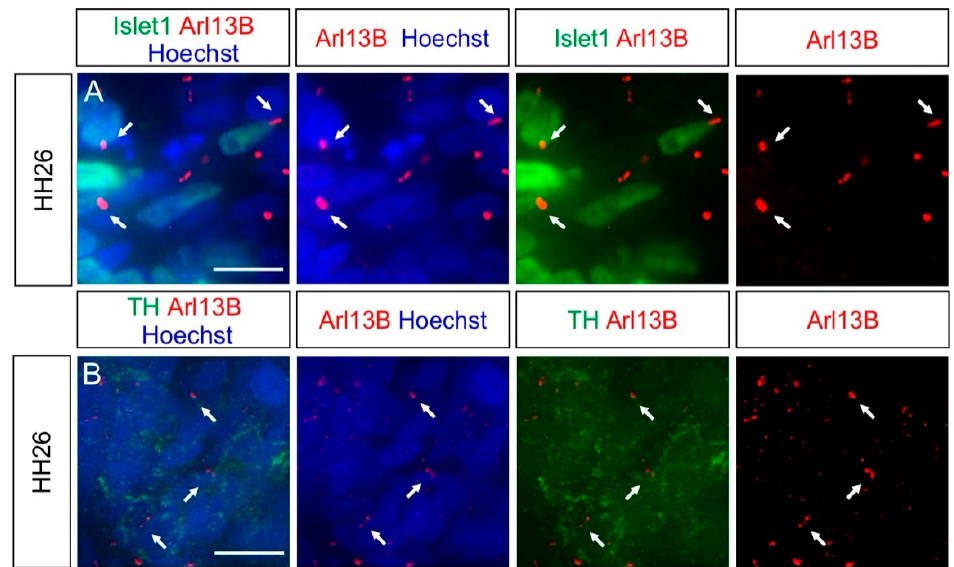
Figure 4. Other NCC derivatives, such as sympathetic ganglia (SG) neurons, possess a primary cilium. Islet-1 ( A ) and TH ( B ) antibodies were used to stain HH26 SG neurons (green). ( A , B ) Arl13B staining revealed that these neurons were ciliated (white arrows). Nuclei were counterstained with Hoechst (blue). Dorsal is up. TH, tyrosine hydroxylase. Scale bars: 10 μ m.